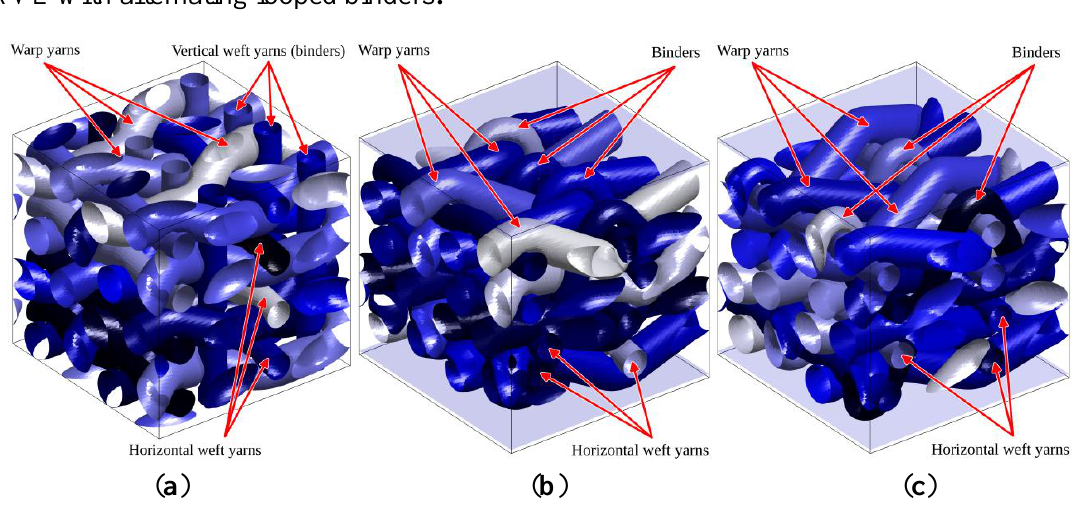
Figure 14. RVEs investigated using the level set-based XFEM simulations: ( a ) 3D RVE with vertical wefts; ( b ) 2.5Da RVE with non-alternating looped binders; and ( c ) 2.5Db RVE with alternating looped binders .